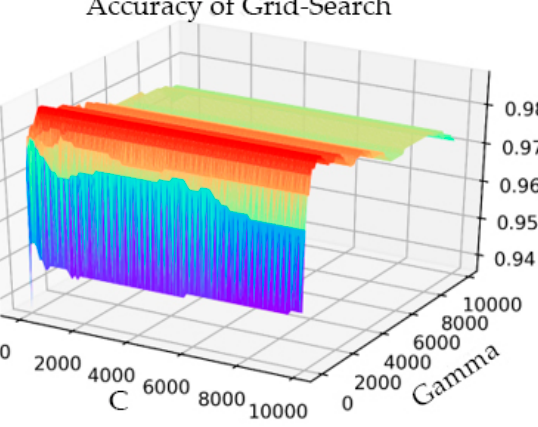
Figure 6. Grid Search parameter optimization process diagram.